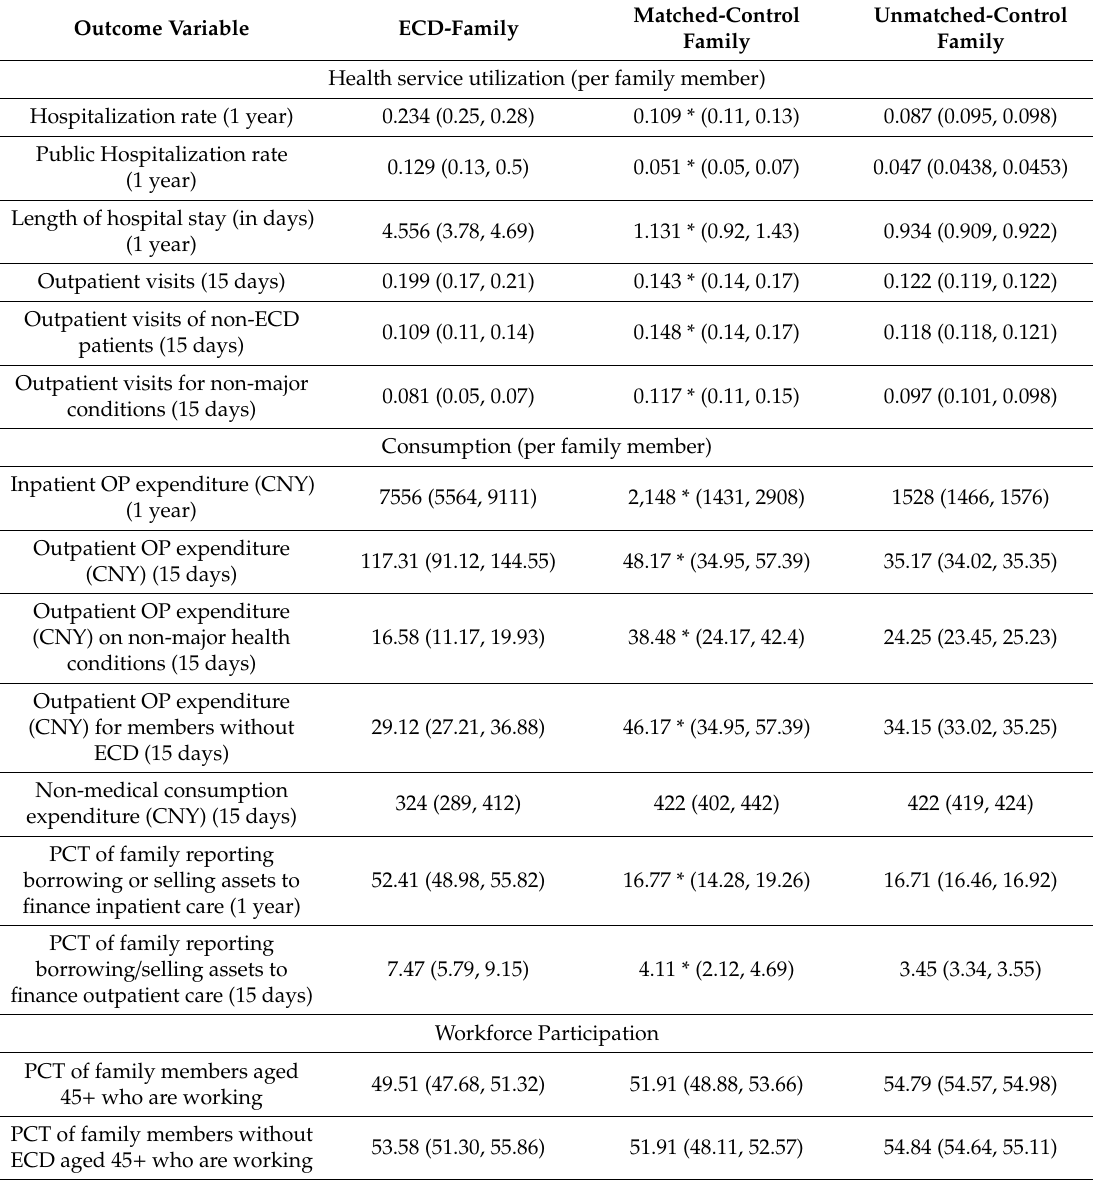
Table 1. Summary of outcome variables by ECD-family and control